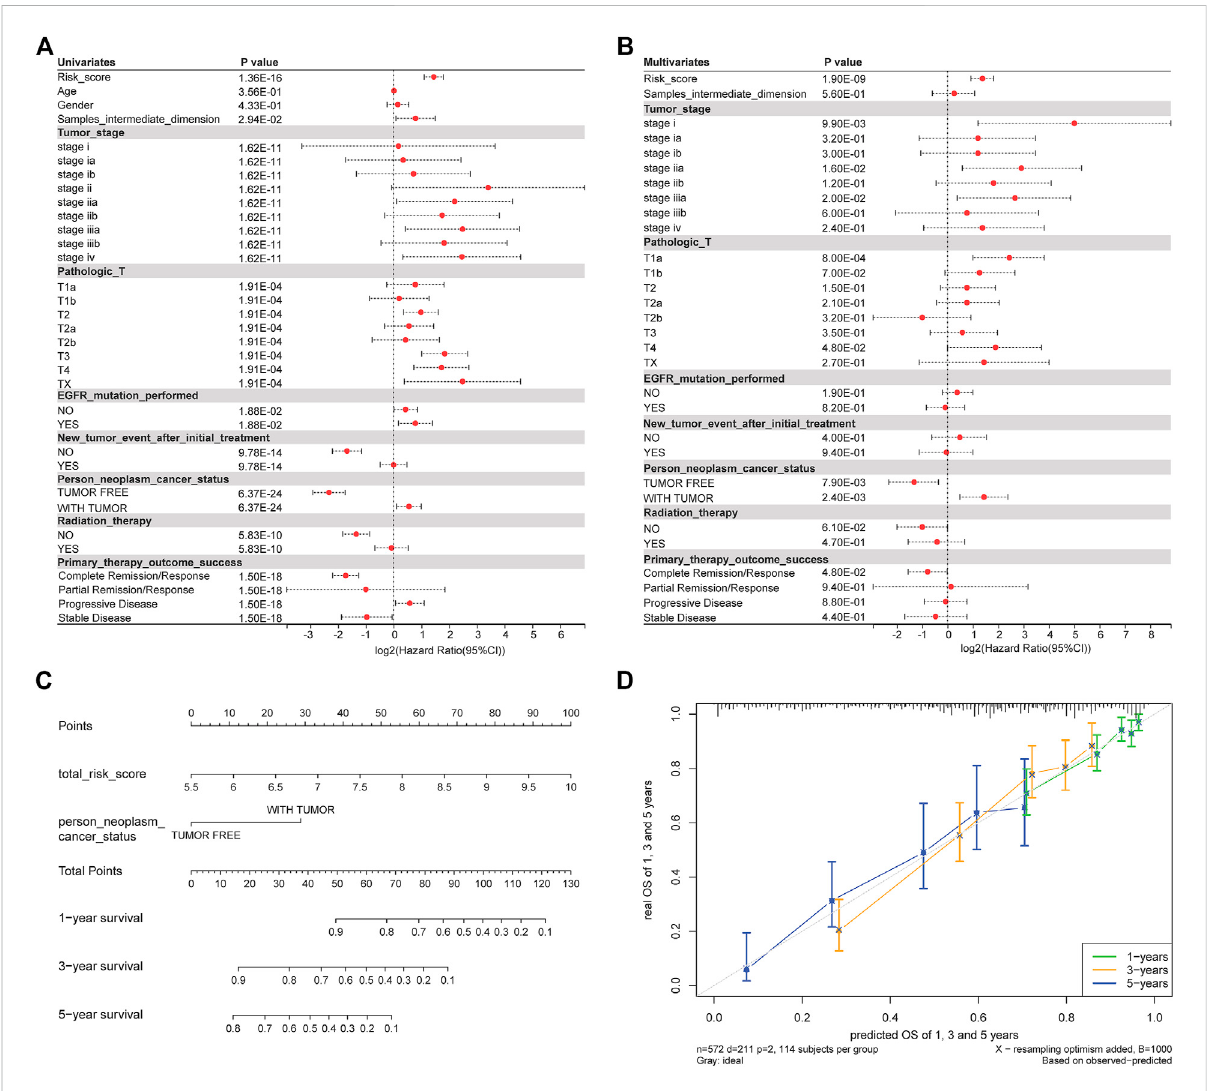
FIGURE 6 Clinical factors are associated with prognosis. (A) Univariate regression analysis results. (B) Results of multivariate regression analysis. (C) Nomogram analysis. (D) Calibration correction